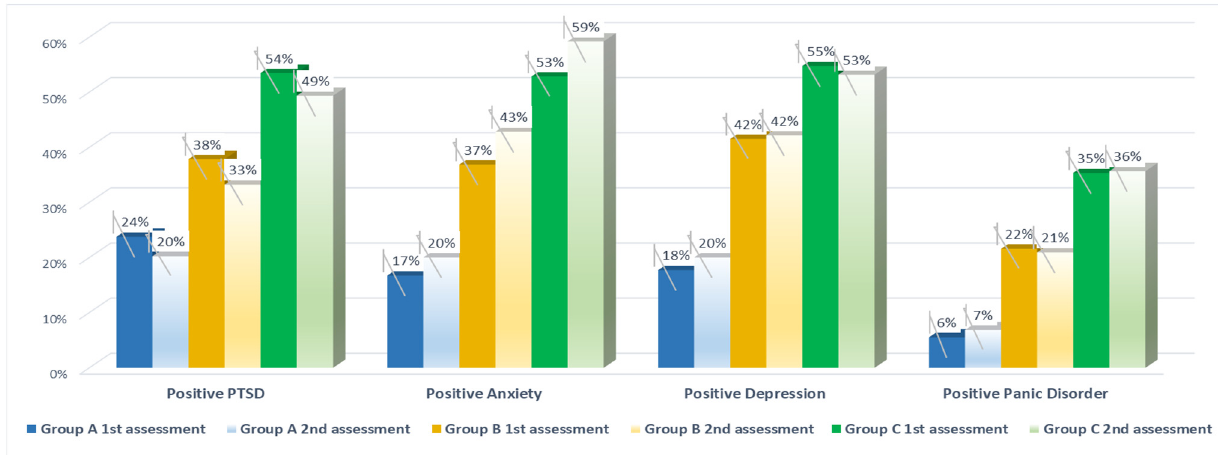
Figure 1. Course of PTSD, anxiety, depression, and panic disorder 68 days after the 1st assessment: Group A: Respondents without preexisting mental illness and no experience of major life event during the pandemic; Group B: With preexisting mental illness and no experience of major life event during the pandemic; Group C: With preexisting mental illness and experience of major stressful life event during the pandemic. “Positive PTSD”, “Positive Anxiety”, “Positive Depression”, and “Positive Panic Disorder” refer to a positive screening result for PTSD, anxiety, depression, and panic disorder respectively, with cut-off points of ≥ 3 for all validated